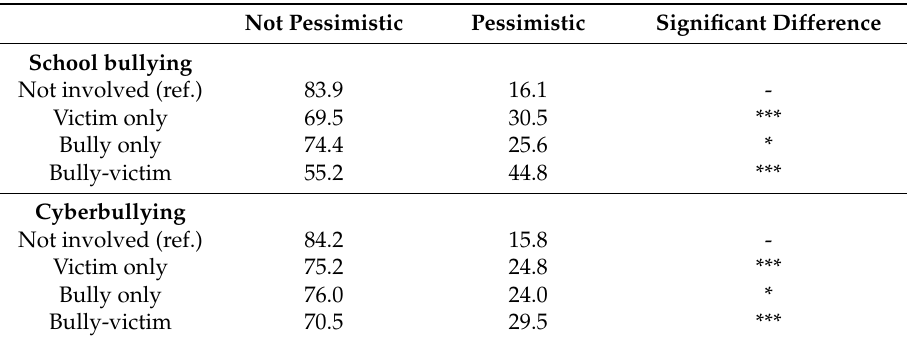
Table 3. Distribution of future orientation, by involvement in bullying. n = 5144. Not Pessimistic